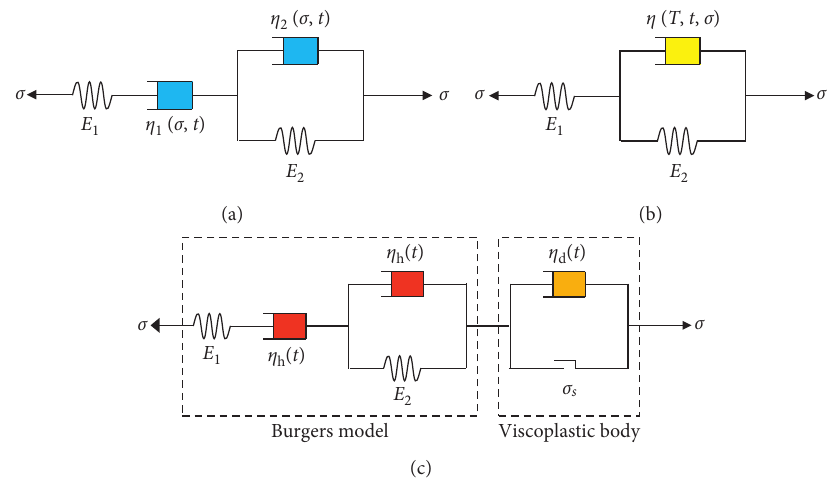
Figure 17: Schematic diagram of the nonlinear creep constitutive model (a) improved by Wang et al. [147], (b) improved by Yang et al. [96], and (c) improved by Liu et al.